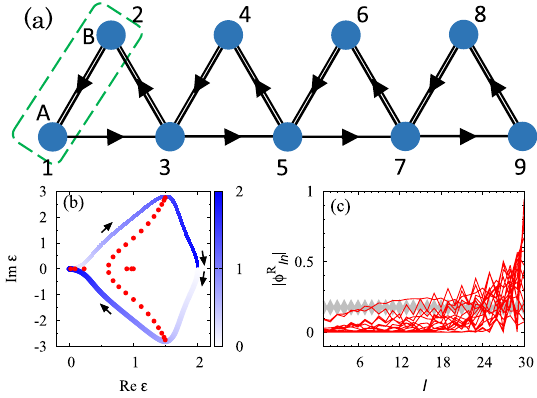
4 with an additional site at I 9 . The arrows describes payoffs. = = 2 L x I holds. Dashed line denotes the unit cell. For J = 1, 2, . . . , + = 0.5 . The data colored with blue are obtained under = − 15 and the = 1, 2, . . . , 2 L x ) as functions of I for L x 15 . Red (gray) = =